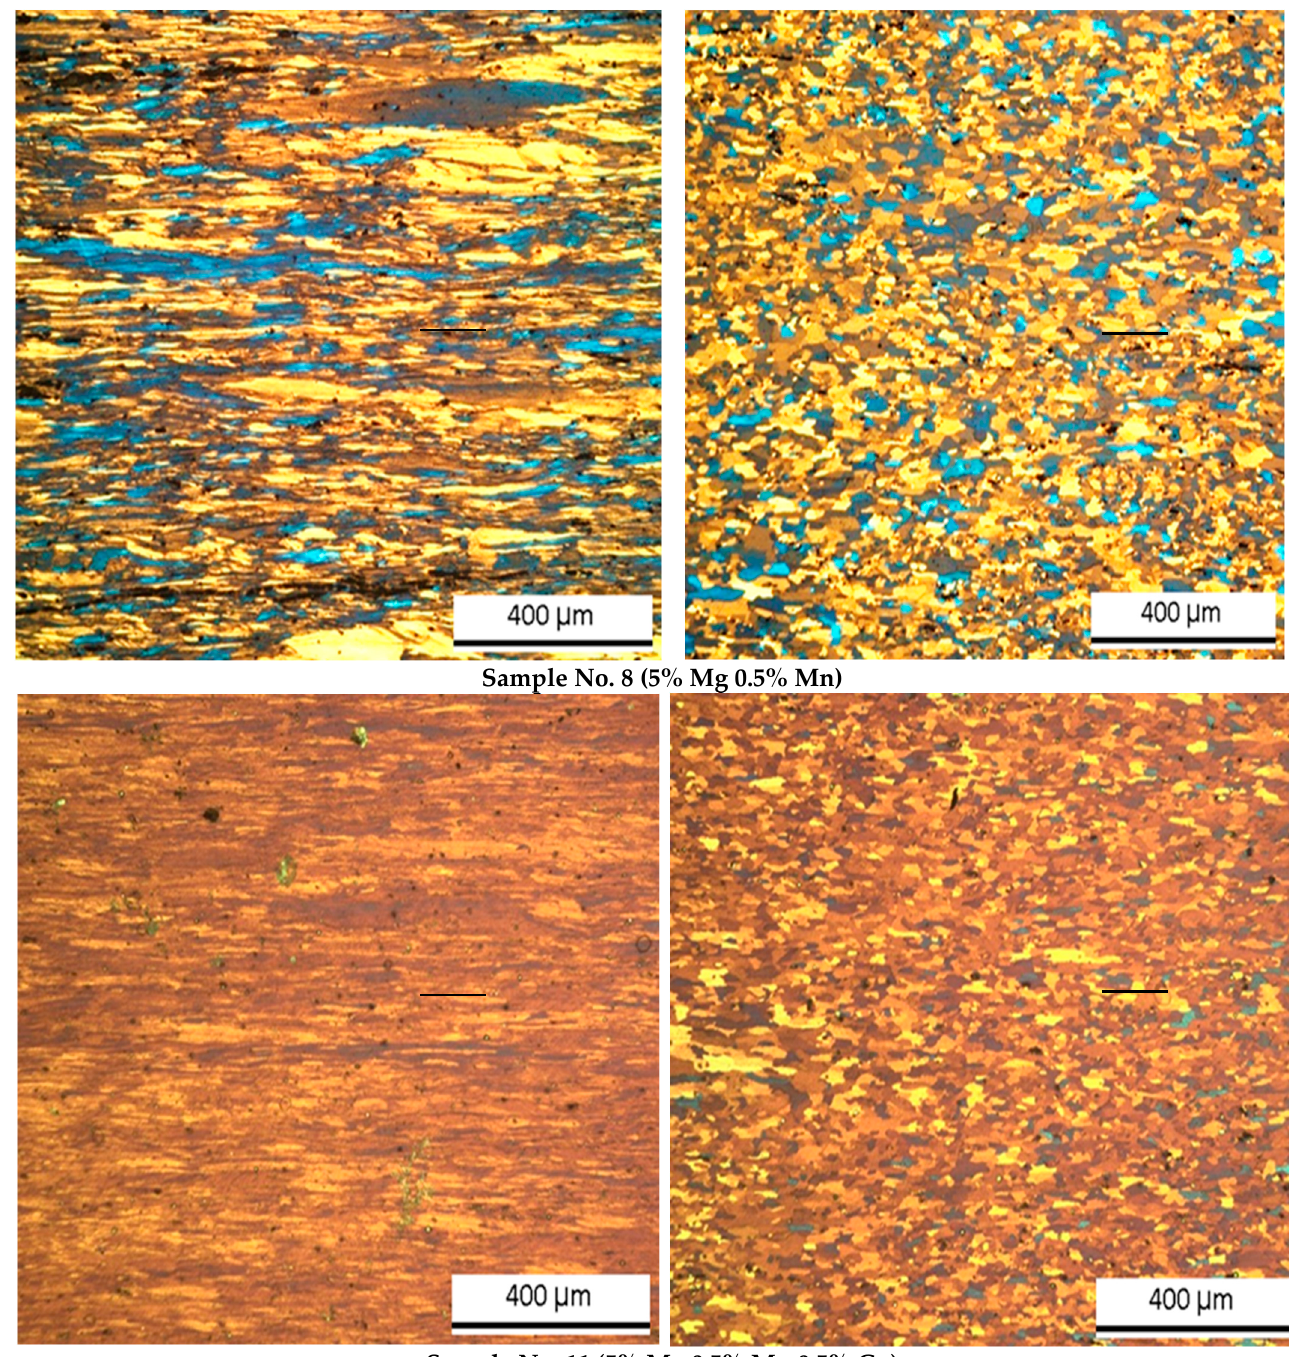
Figure 1. Grain structure of hot-rolled and annealed samples related to alloy chemical composition. The EBSD data for the 5Mg0.5Mn0.5Cu alloy in the annealed state in Figure 3 shows the presence of small-sized grains of 30 µm in which low-angle boundaries were not found. This, as well as the fact that the grains changed their shape and size, indicates that recrystallization was completed. Small inclusions of a non-recrystallized structure were observed. This suggests that recrystallization in these volumes was blocked by the action of finely dispersed intermetallic particles. In general, the EBSD data were in good agreement with the optical microscopy data. Based on analysis of inverse pole figures and pole figures, pronounced texture components were absent. This suggests that PNS is